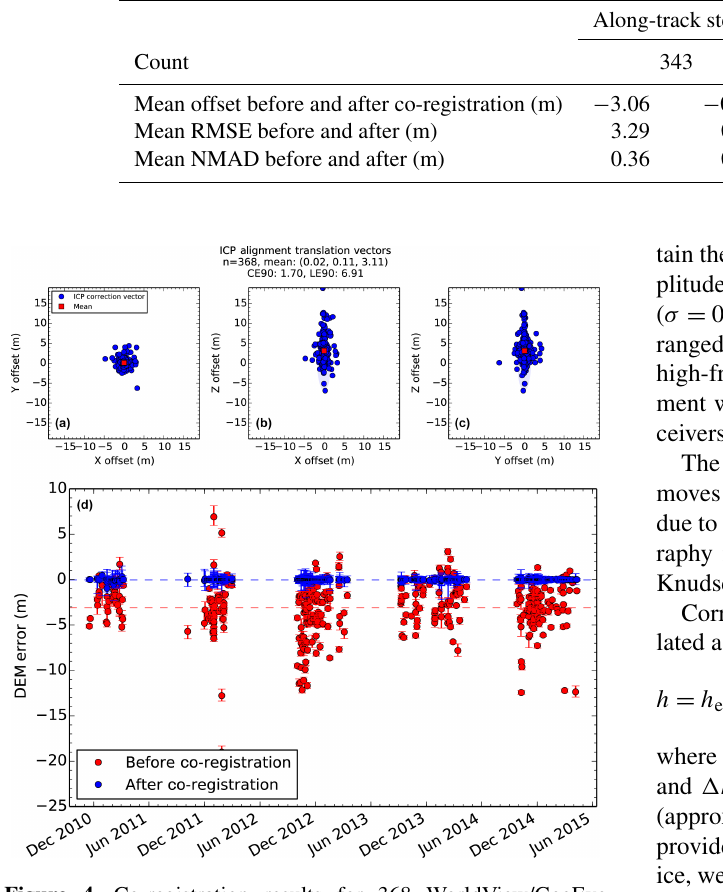
Figure 4. Co-registration results for 368 WorldView/GeoEye DEMs over the PIG catchment (see Shean et al., 2016, for addi- tional details). (a–c) Iterative closest point (ICP) translation vec- tor components required to co-register each DEM with filtered al- timetry data. (d) Median DEM error (DEM – altimetry) with error bars showing 16%–84% spread for each DEM, before (red) and after (blue) co-registration. Horizontal dashed lines show mean er- ror values. The 2011/2012 cross-track stereo DEMs display larger errors before co-registration. After co-registration, bias is removed and residual error spread for individual DEMs is typically <0.5– 1m, as summarized in Table